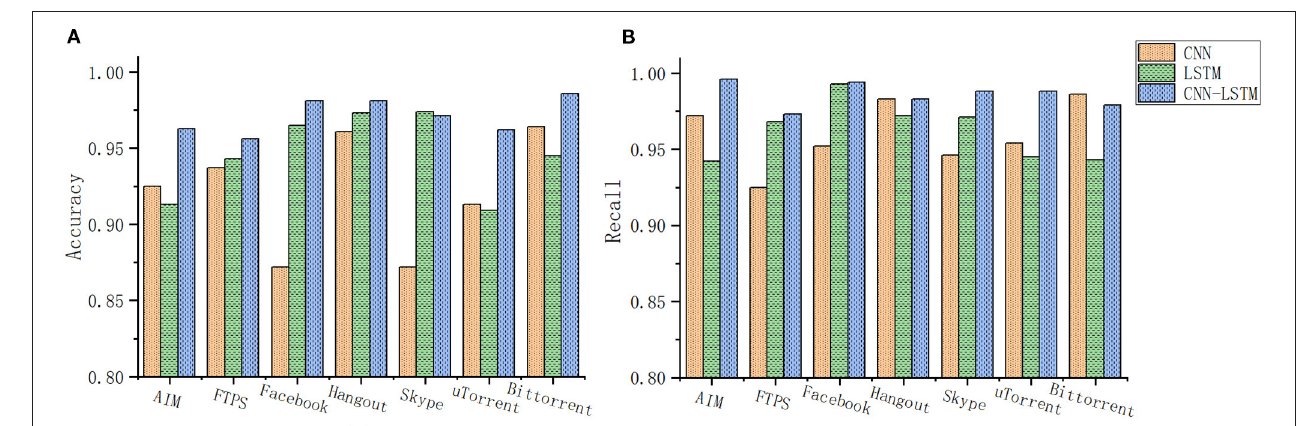
FIGURE 8 | (A) CNN-LSTM joint network application classification accuracy rate. (B) CNN-LSTM joint network application classification recall rate.